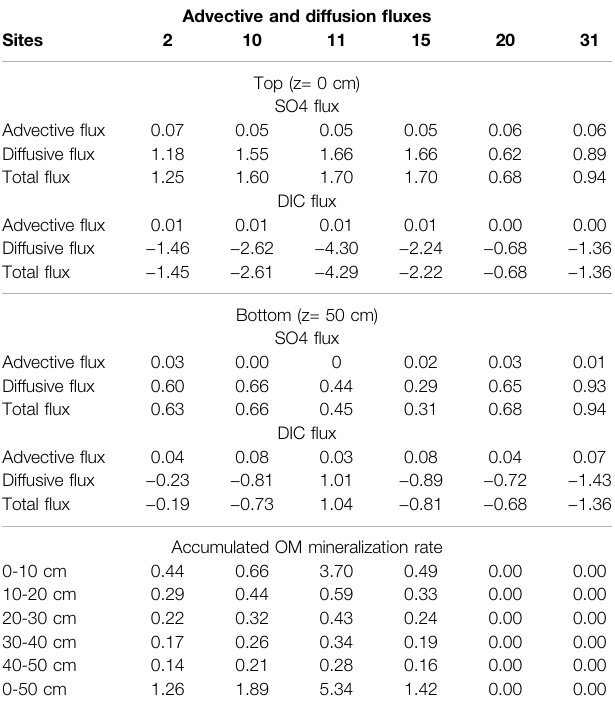
TABLE 2 | Modeled diffusive and advective fl uxes of DIC and SO 4 and the accumulated OM mineralization rate for all the 6 sediment core sites. The fl uxes and the rates are given in mmol m − 2 d − 1